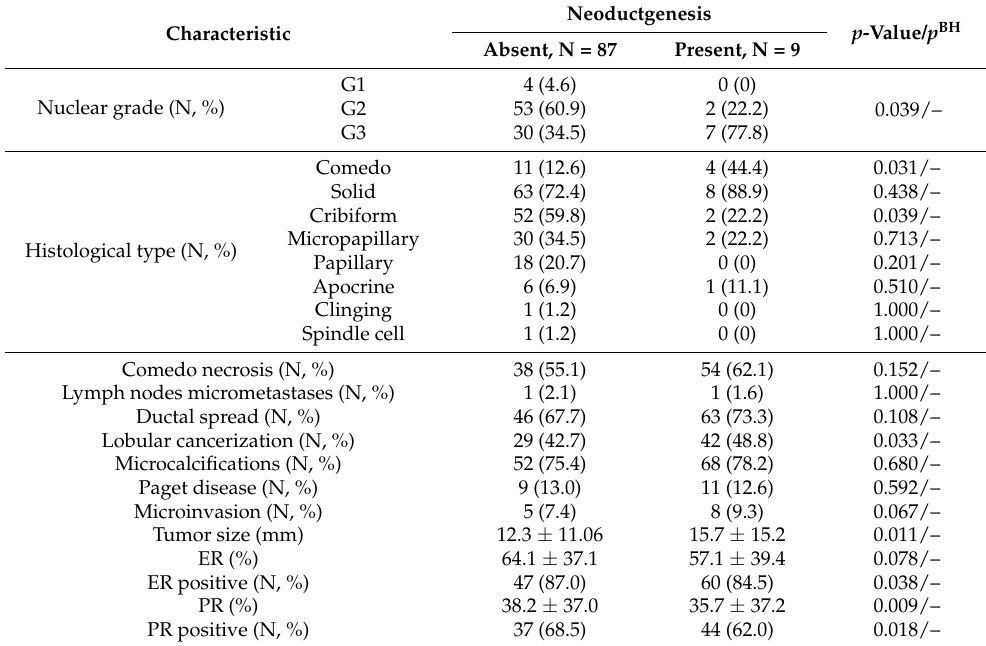
Table 4. Comparison of histological features in DCIS with or without neoductgenesis as scores